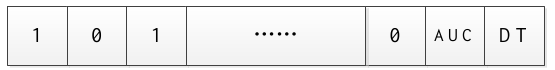
Figure 2. Code structure.